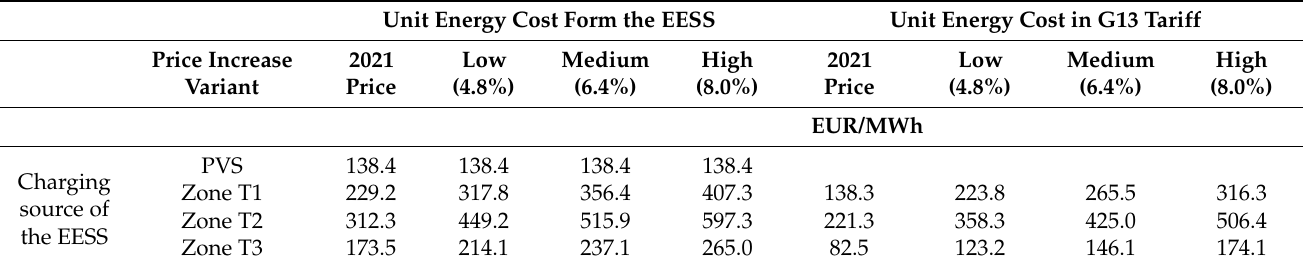
Table 4. Energy prices for various combinations of charging sources in comparison to energy price from grid.